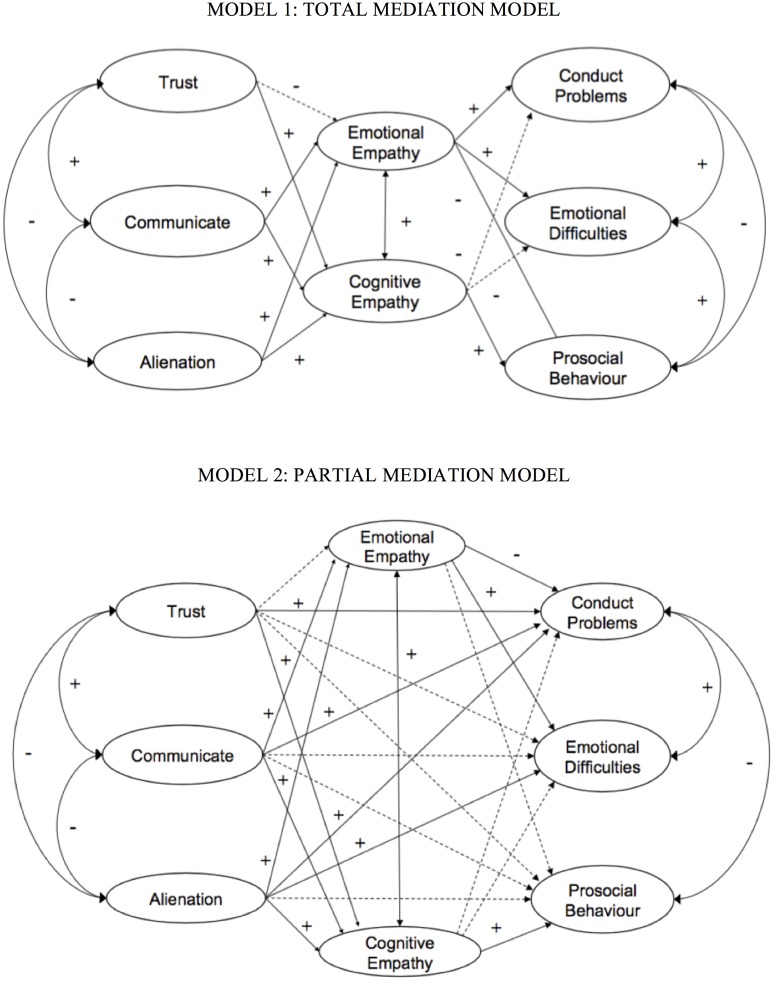
Initial models of full mediation (1) and partial mediation (2).Note: Continuous lines represent a significant relationship with p < .01, dotted lines represent non-significant relationships. The relationships of the factors with their indicators have not been drawn for simplicity.